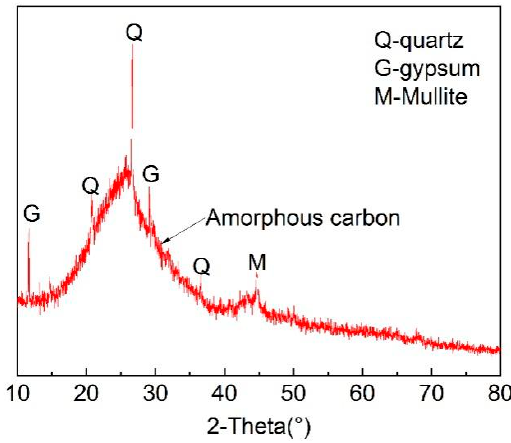
Figure 8. XRD pattern of coal gasification fine slag.